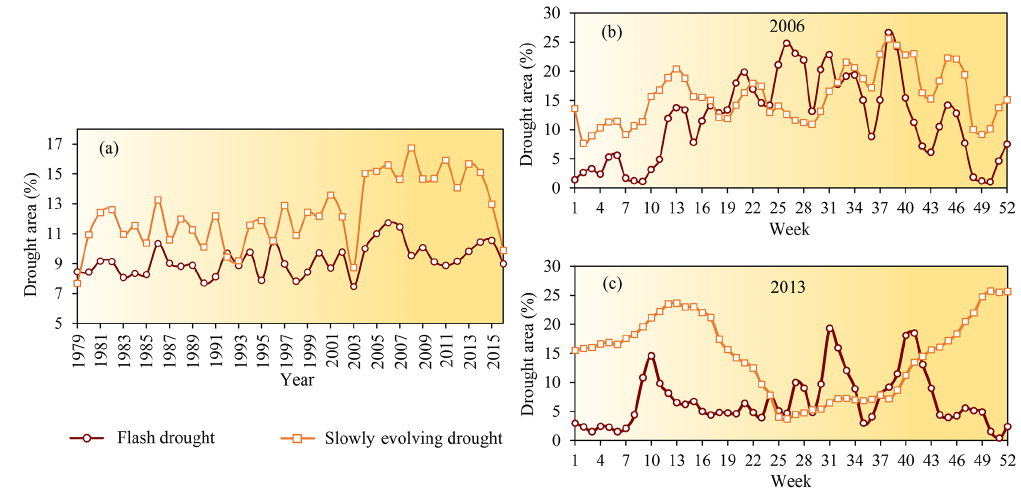
Figure 9. Time series of flash drought area and slowly evolving drought area derived from ERA SM series during 1979–2016, as well as in the typical years of 2006 and